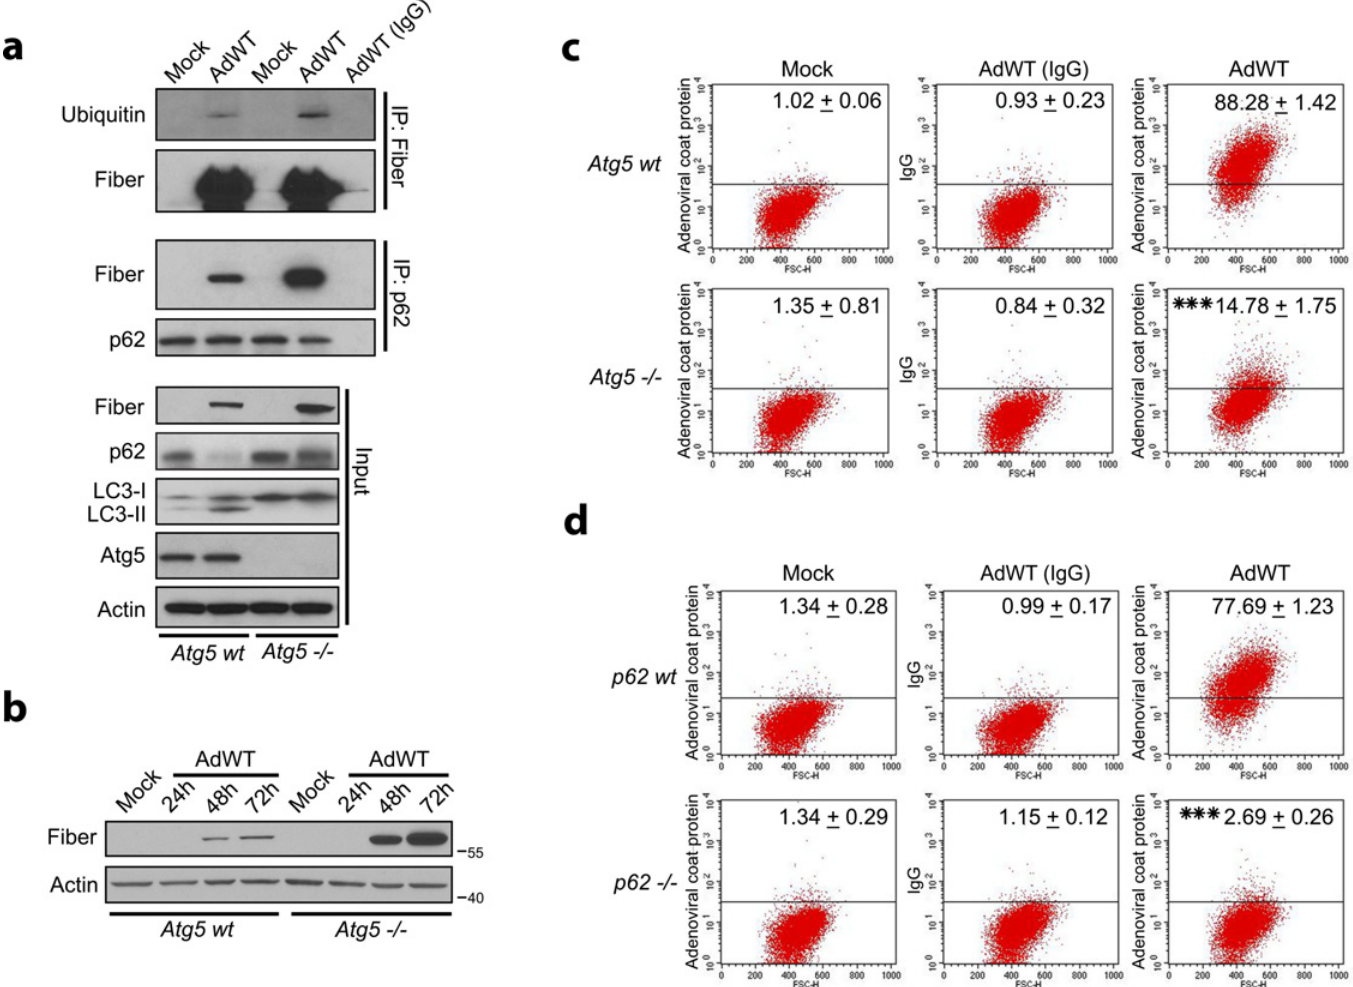
Fig 3. Autophagy is involved in the processing of adenovirus-derived epitopes. ( a ) Cell lysates from Atg5wt or Atg5-/- MEFs infected with AdWT (50 MOI) were analyzed for fiber/ubiquitin and fiber/p62 protein complexes. LC3-I to LC3-II conversion and p62 expression levels were analyzed in an input sample (5%). Actin is shown as a loading control. ( b ) Cell lysates from Atg5wt and Atg5 -/- MEFs were mock-infected or infected with AdWT (50 MOI) for the indicated times and analyzed for adenoviral fiber expression. Actin was used a loading control. ( c ) Atg5wt and Atg5-/- MEFs were mock-infected or infected with AdWT adenovirus (50 MOI) for 48 h and then stained with antibodies to adenoviral coat proteins, incubated with APC-conjugated secondary antibody, and analyzed by flow cytometry. IgG isotype was used as a control. Propidium iodide was used to assess cell viability. Data are shown as percentage of APC-positive cells (mean ± SD) of three independent experiments. *** P < 0.001 (percentage of APC-positive in AdWT-infected Atg5wt cells vs. AdWT- infected Atg5 -/- cells) (unpaired, two-tailed Student t-test ). ( d ) p62wt and p62-/- MEFs were infected with AdWT adenovirus (100 MOI) for 48 h and then stained with antibodies against adenoviral coat proteins, incubated with APC-conjugated secondary antibodies, and analyzed by flow cytometry. IgG isotype was used as a control. Propidium iodide was used to assess cell viability. Data are shown as percentage of APC-positive cells (mean ± SD) of three experiments. *** P < 0.001 (percent of APC-positive cells in AdWT-infected p62 -/- vs. AdWT-infected p62wt cells) (unpaired, two-tailed Student t-test ).